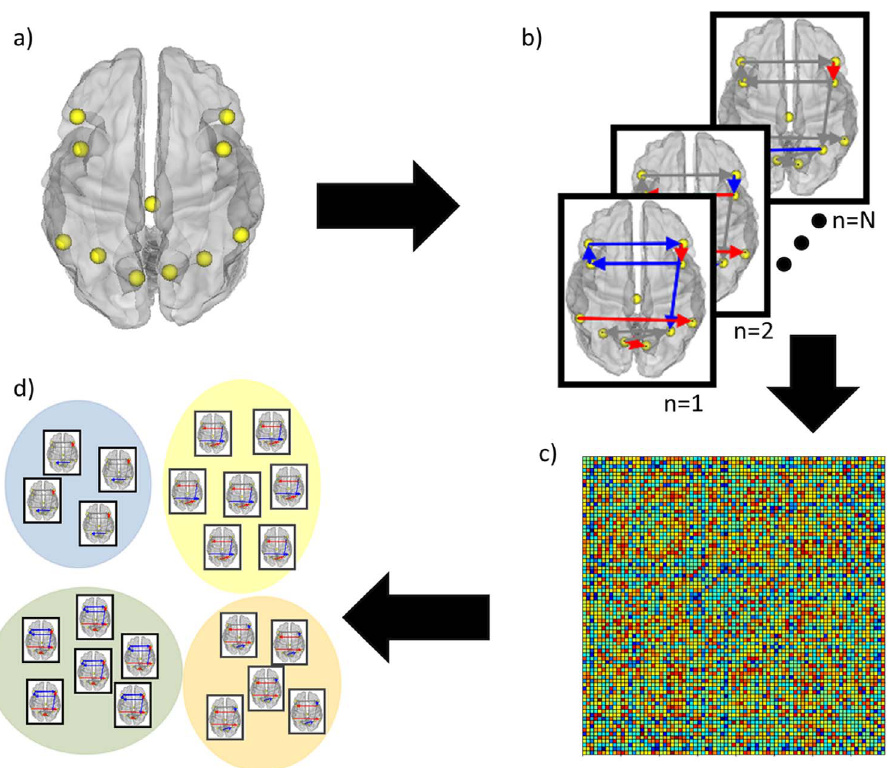
Figure 1. Schema of analytic process. Analysis were conducted using the following steps: a) obtain timeseries of functional MRI observations from regions of interest; b) arrive at directed functional connectivity maps for each individual using GIMME; c) correlate each individual’s vector of connection weights with every other individual’s vector for a similarity matrix; d) apply Newman’s modularity maximization algorithm to similarity matrix to arrive at subgroups of individuals based on similar brain connectivity patterns.